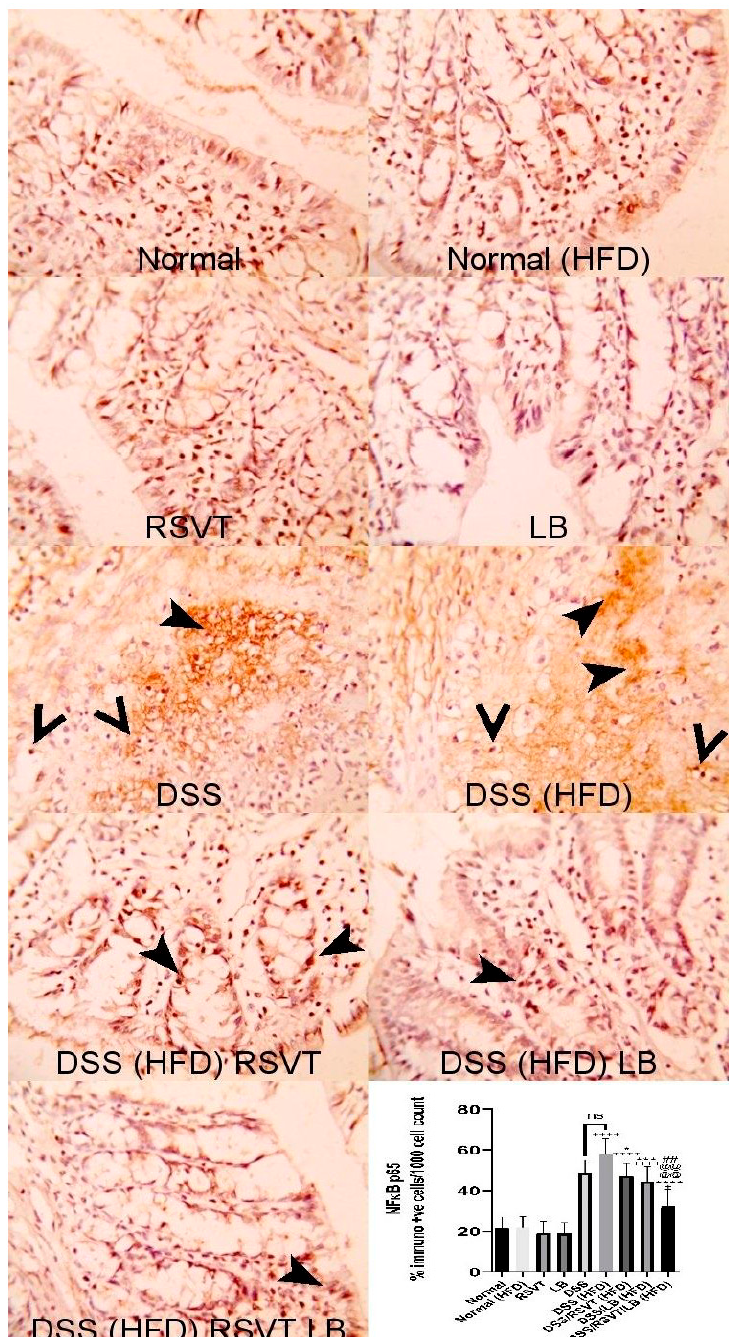
Figure 3. Photomicrographs of colon specimens showing NF-kB p65 immunoexpression. Normal, Normal (HFD), RSVT, and LB groups display normal NF-kB p65 immunoexpression. The DSS and DSS (HFD) groups display increased immunoexpression (notched arrowheads) and nuclear staining (open arrowheads). DSS/RSVT (HFD), DSS/LB (HFD) and DSS/RSVT/LB (HFD) rat groups showing a significant decrease in NFkB p65 immunoexpressiom compared with DSS/HFD ( p < 0.05, p < 0.001, and p < 0.0001, respectively). IHC, × 400. +, p < 0.05 vs. Normal (HFD); ++++, p < 0.0001 vs. Normal (HFD); *, p < 0.05 vs. DSS (HFD); ***, p < 0.001 vs. DSS (HFD); ****, p < 0.0001 vs. DSS (HFD); ##, p < 0.01 vs. DSS/LB (HFD); @@@@, p < 0.0001 vs. DSS/RSVT (HFD); ns,